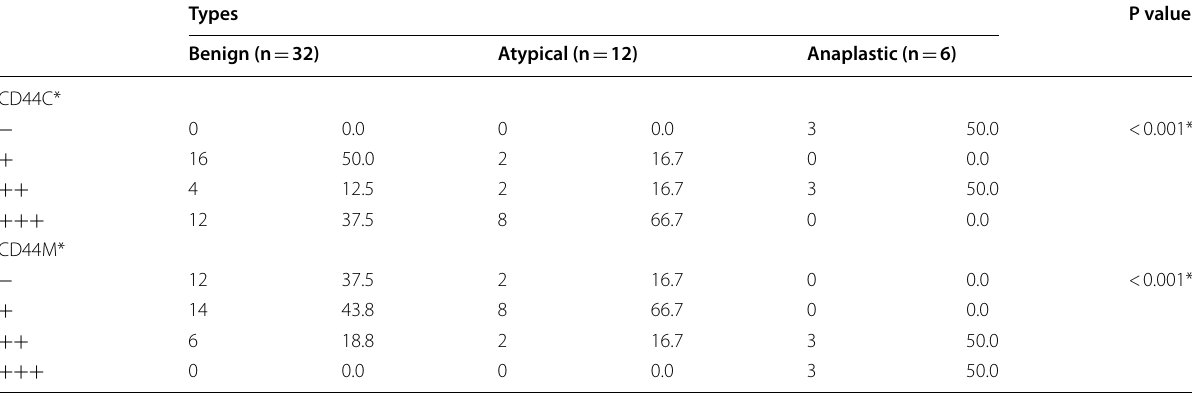
CD44C*, cytoplasmic expression; CD44M*, Membranous